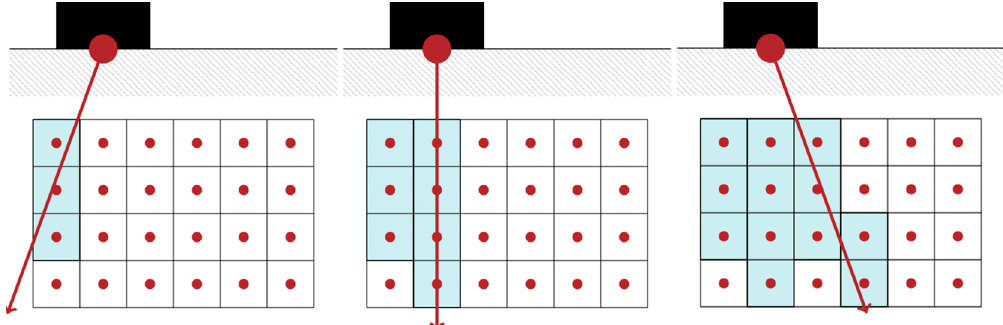
Figure 1. Sketch illustrating how rays are rasterized and projected to the equispaced voxels used for imaging by a line tracing algorithm.